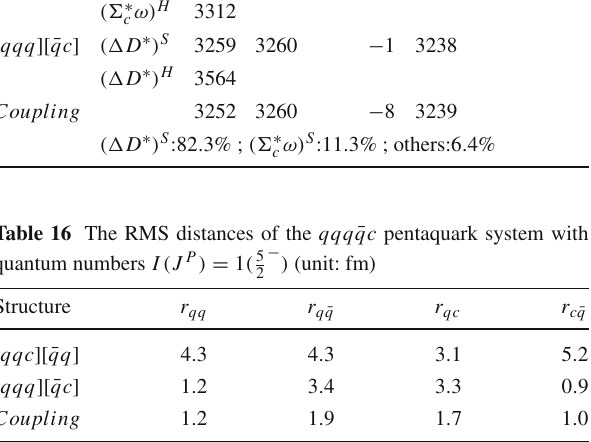
Table 13 The energies of the qqq ¯ qc pentaquark system with quantum − ) (unit: MeV) numbers I ( J P ) = 1 ( 1 2 Structure